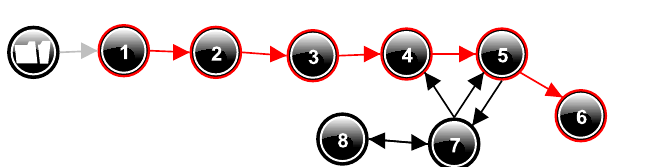
Figure 3. State-graph showing the behaviour states generated for the enzymatic reaction model. Each state (black circle) refers a qualitative distinct behaviour that the system may take on. Arrows refer to state- transitions, e.g. when the system manifests the behaviour represented by state 7 this may change into the behaviours represented by state 4, 5 or 8. Note that the numbers are merely identifiers (they do not refer to state order). The BP [1 → 2 → 3 → 4 → 5 → 6] is shown in red, meaning it is selected by the